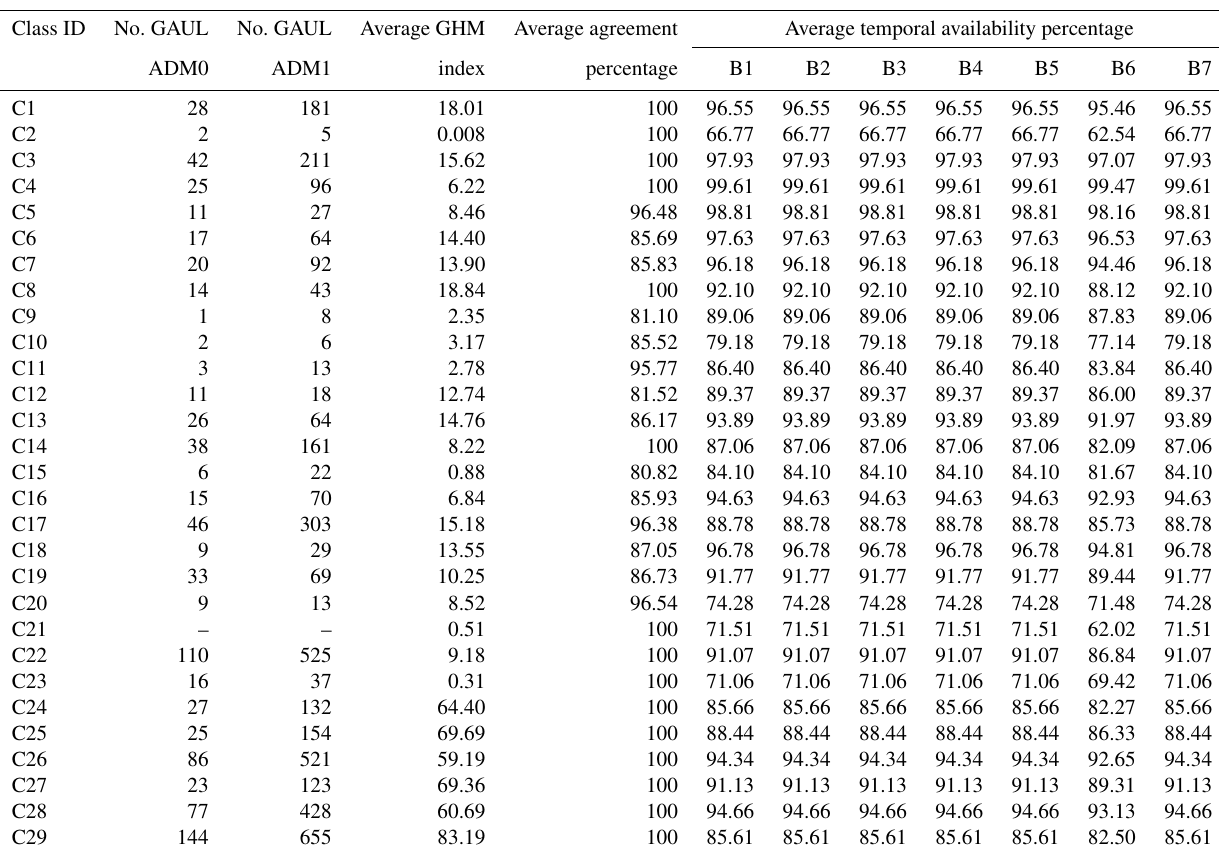
Table 10. Description of the number of GAUL partitions ADM0 and ADM1, the average GHM index, the average agreement percentage, and the average temporal availability percentage of each spectral band (B1 to B7) for the balanced version of the data. The number of ADM0 and ADM1 partitions for the class “marine water bodies” (C21) is not provided because the GAUL partitions do not cover the seas and